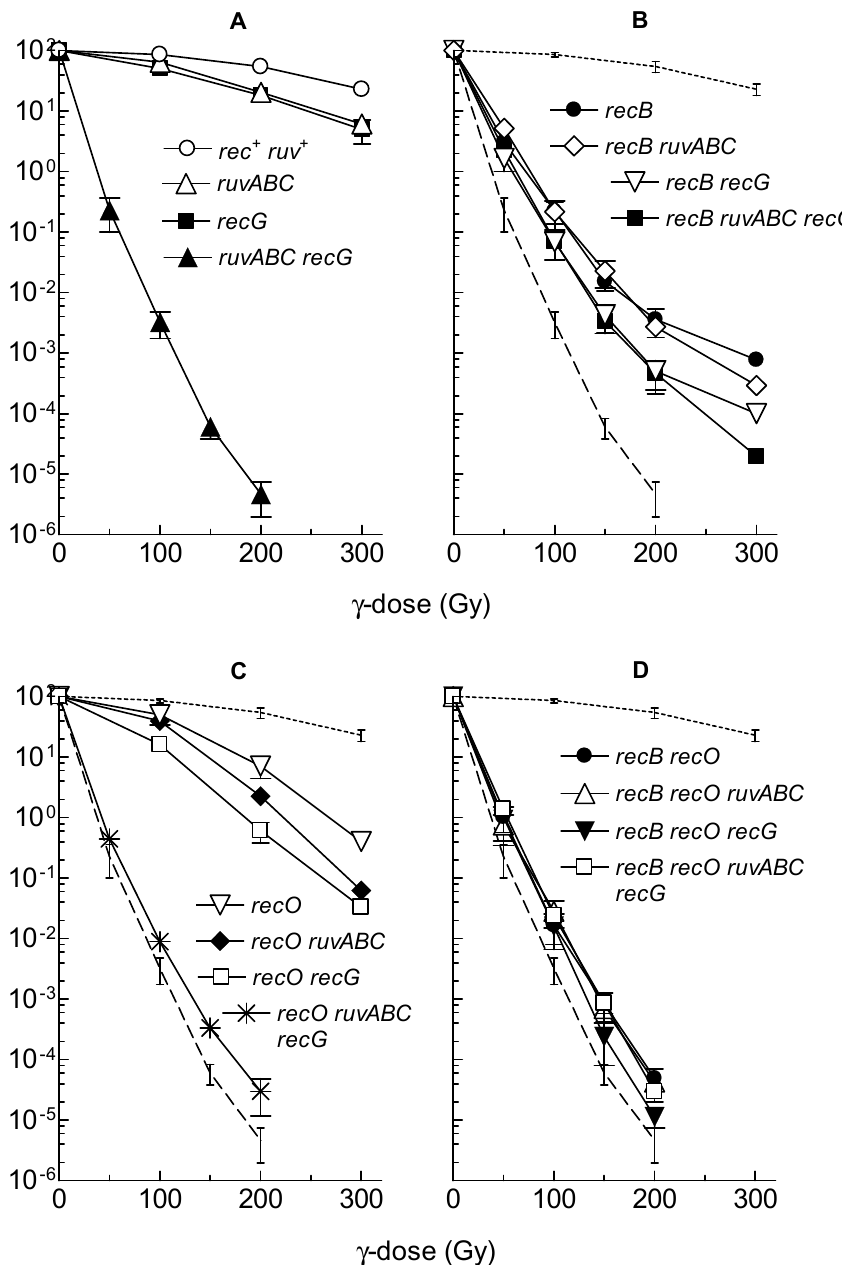
Figure 5. Survival of different E. coli mutants after γ -irradiation. The data for each strain are averages of results from at least three independent experiments, with error bars representing standard deviations. The strains used are: ( A ) rec + ruv + (LMM2629), ruvABC (LMM3188), recG (LMM3196), ruvABC recG (LMM3610); ( B ) recB (LMM3183), recB ruvABC (LMM3625), recB recG (LMM3626), recB ruvABC recG (LMM4134); ( C ) recO (LMM3545), recO ruvABC (LMM3600), recO recG (LMM3601), recO ruvABC recG (LMM3604); ( D ) recB recO (LMM3599), recB recO ruvABC (LMM3602), recB recO recG (LMM3603), recB recO ruvABC recG (LMM3605). Dotted lines and dashed lines on panels B, C and D represent survival of the wild-type ( rec + ruv + ) and the ruvABC recG mutant, respectively. Statistical analysis is provided in Tables S5 and S6.